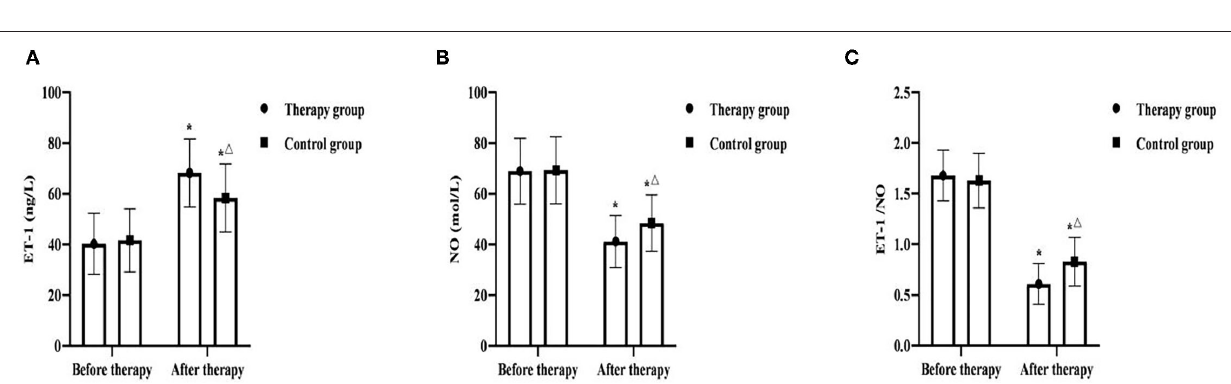
FIGURE 3 | Comparison of oxidative stress indicators between the two groups ( x ± s , n = 55). (A) was comparison of LPO between the two groups. (B) was comparison of MDA between the two groups. (C) was comparison of SOD between the two groups. * P < 0.05 was compared with the same group before therapy, 1 P < 0.05 was compared with the control group after therapy.